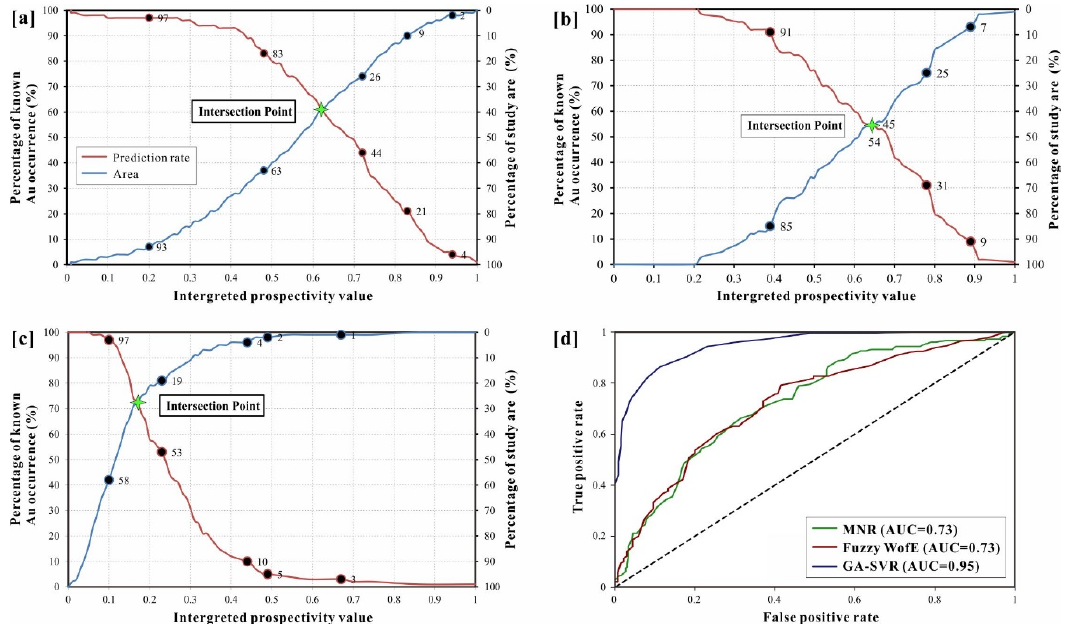
Figure 8. Prediction-area (P-A) plots and receiver operating characteristic (ROC) curves for different prospectivity models. ( a ) PA plot of MNR; ( b ) PA plot of fuzzy weights-of-evidence (WofE); ( c ) PA plot of GA-SVR; ( d ) ROC curves of three prospectivity models.